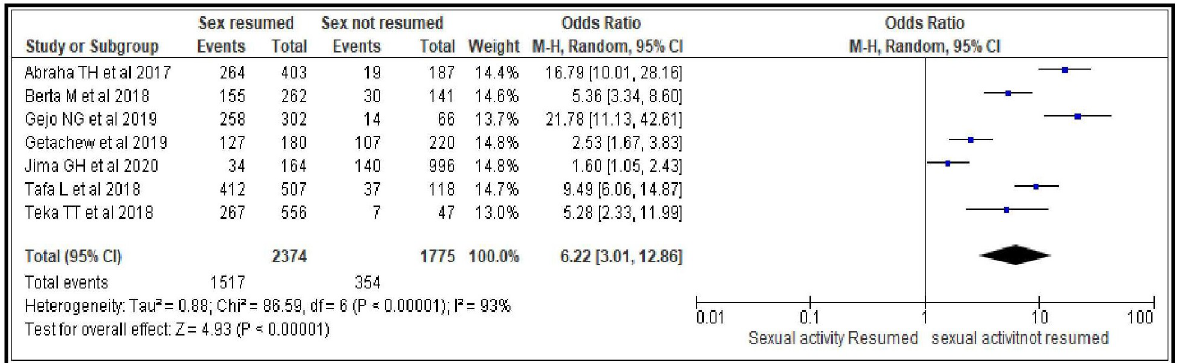
PLOS ONE | https://doi.org/10.1371/journal.pone.0270055 February 7,